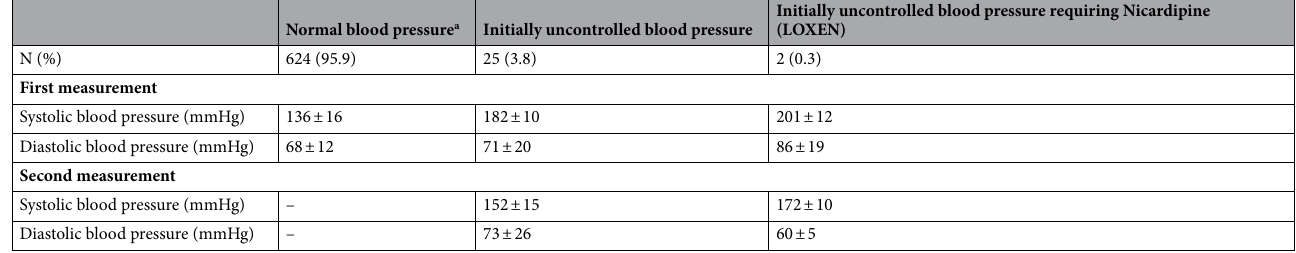
Table 3. Preoperative blood pressure measurements.